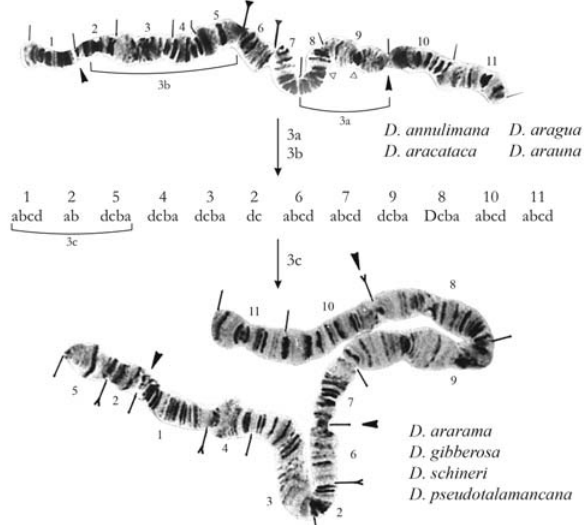
Figure 10 - Relationships among eight Drosophila species of the annulimana group based on the inversions found in chromosome 3. It was not possible to establish the homology of the band sequences of this chro- mosome in D. arapuan and D. arassari . Subdivisions (abcd) have no cor- respondence in the photomicrographic map and were included to facilitate understanding.